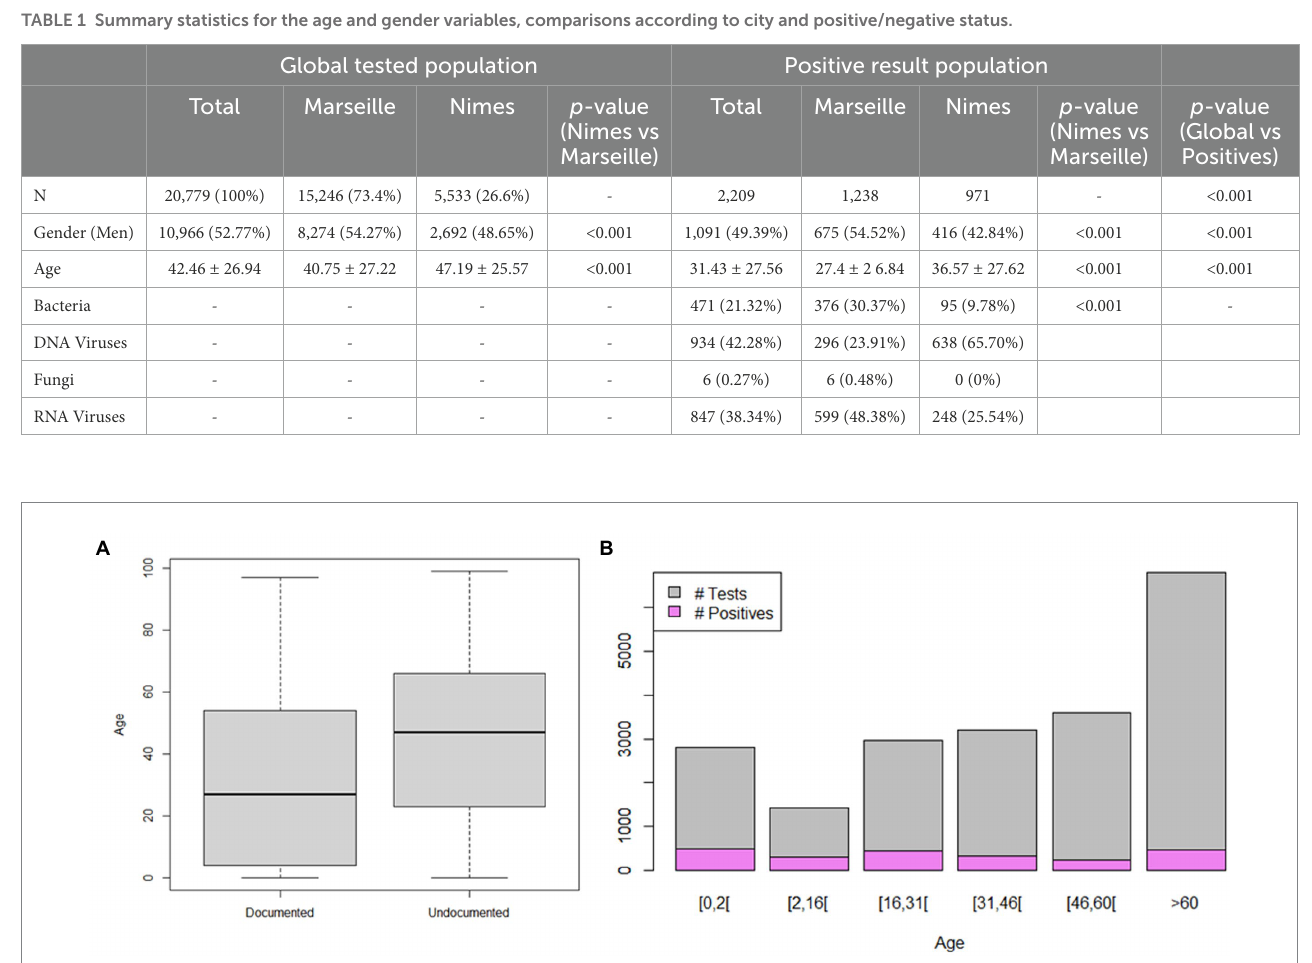
FIGURE 1 Distribution of meningitis cases according to patient age. (A) Boxplot of total negative (undocumented) and positive (documented) meningitis cases according to patient age. (B) Bar plot of meningitis cases and positive diagnoses according to patient age